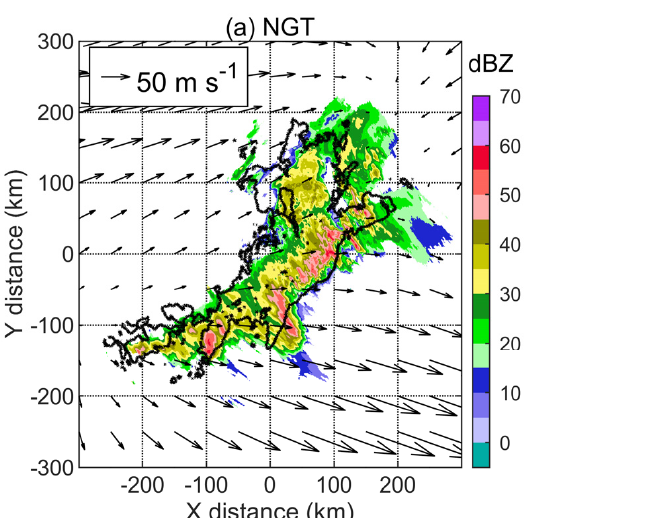
Figure 9. CSI of the 60 min extrapolating prediction by NGT and OF for ( a ) Z > 20 dBZ, ( b ) Z > 30 dBZ, ( c ) Z > 40 dBZ, and ( d ) NGT—OF on 17 May 2020. The prediction starts at 9:05 UTC on 20 May 2011.